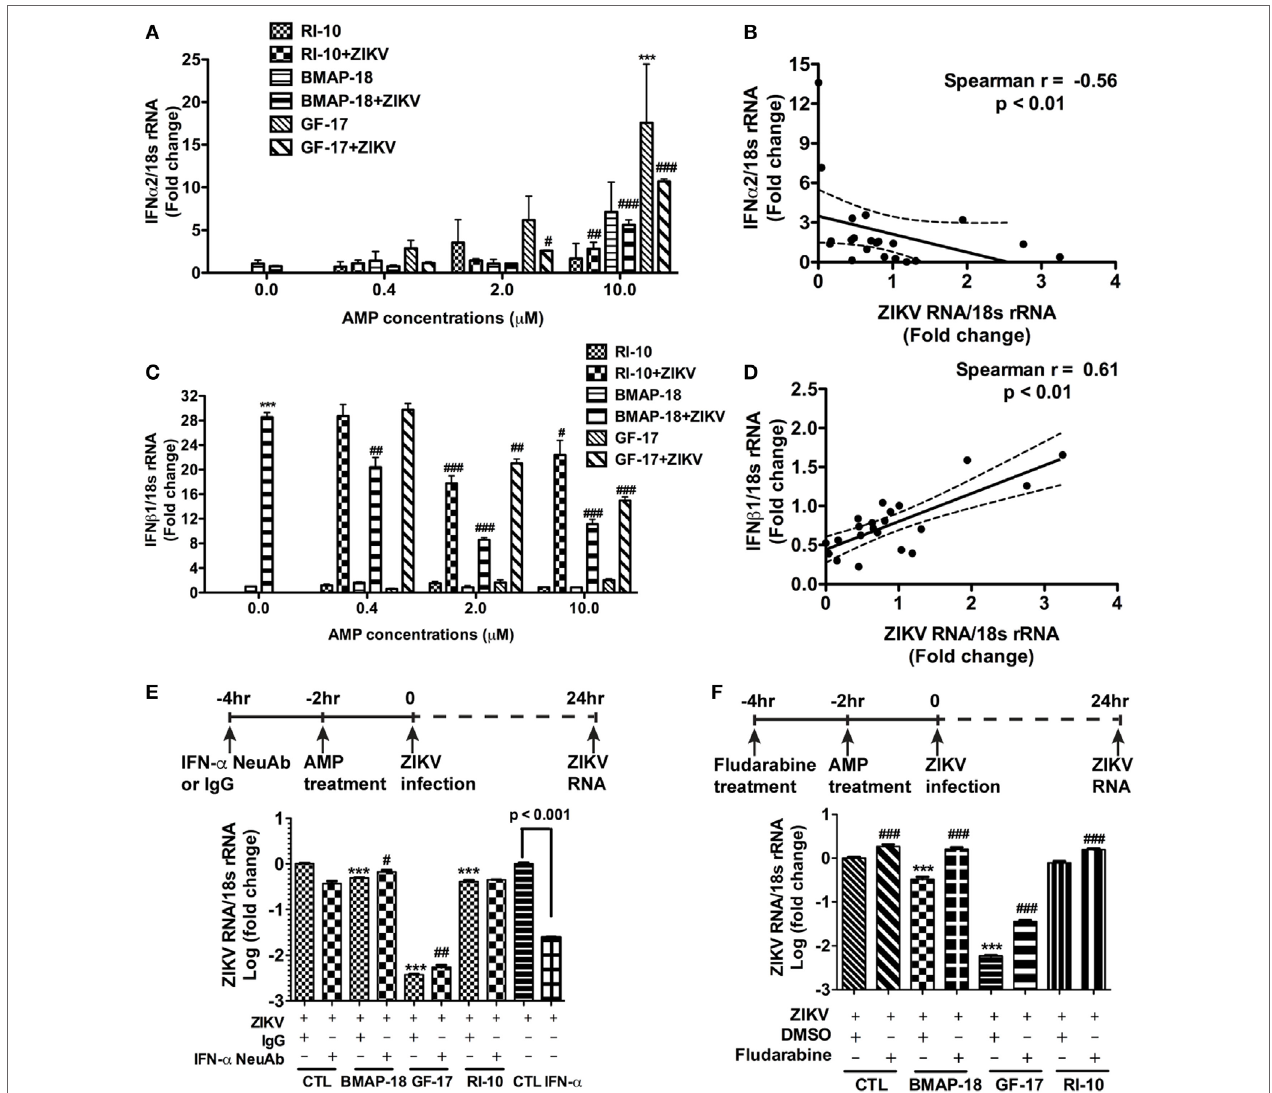
FigUre 6 | Antimicrobial peptides (AMPs) are negatively correlated with IFN- α 2 expression in ZIKV-infected astrocytes. (a–D) Astrocytes were infected with Zika virus (ZIKV) at the MOI of 0.5 and treated with doses of AMPs ranging from 0.4 to 10 µM. After 24 h, the cultures were washed and treated with same doses of AMPs in fresh medium for another 24 h. RNA was isolated from cells and the expression of IFN- α 2 (a) and IFN- β 1 (c) was determined through real-time RT-PCR. Data were normalized to 18-s rRNA and presented as fold change compared with ZIKV group. Correlation of the IFN- α 2 (B) and IFN- β 1 (D) with ZIKV infection levels was determined by Spearman correlation. *** p < 0.001, as compared with the uninfected control group. # p < 0.05, ## p < 0.01, ### p < 0.001, as compared with the ZIKV group (ANOVA, N = 3). (e,F) Human astrocytes were pretreated with anti-IFN- α neutralizing antibodies (e) or 1-µM fludarabine (F) for 2 h, then treated with AMPs for 2 h before ZIKV infection at the MOI of 0.5. Rabbit IgG and DMSO were used as control for anti-IFN- α neutralizing antibodies and fludarabine, respectively. At 24 h after infection, total RNA was collected and ZIKA RNA was detected through real-time RT-PCR. Recombinant IFN- α 2 was tested for ZIKV inhibition at 1000 units/mL. Data were normalized to 18-s rRNA and presented as fold change in log scale compared with ZIKV group. CTL, control. *** p < 0.001, compared with the corresponding ZIKV group treated with control IgG or DMSO; # p < 0.05, ### p < 0.001, compared with the ZIKV group treated with the same AMP (ANOVA, N =